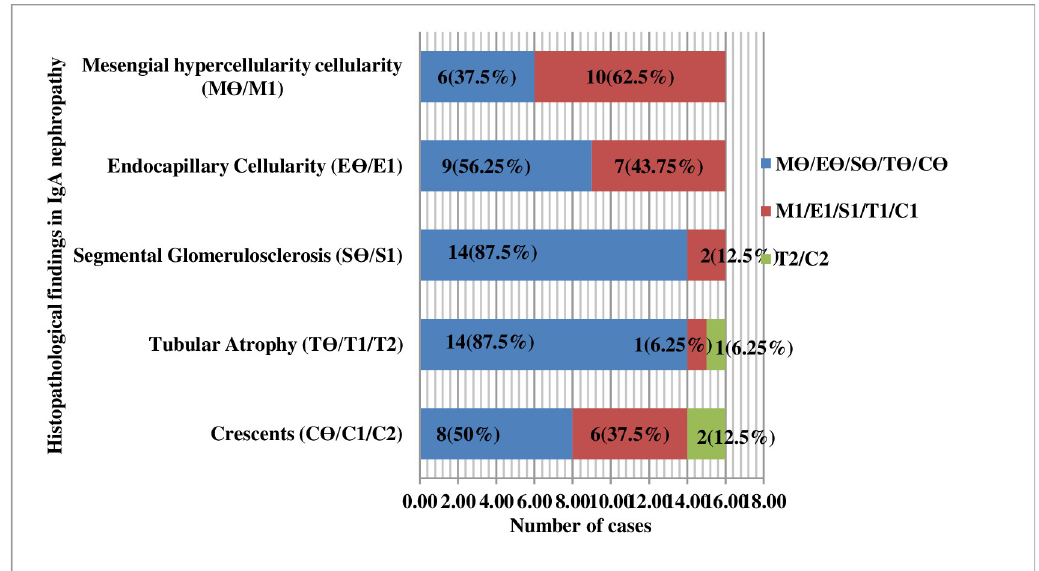
Fig 6. Histopathological findings of Ig A nephropathy (N =